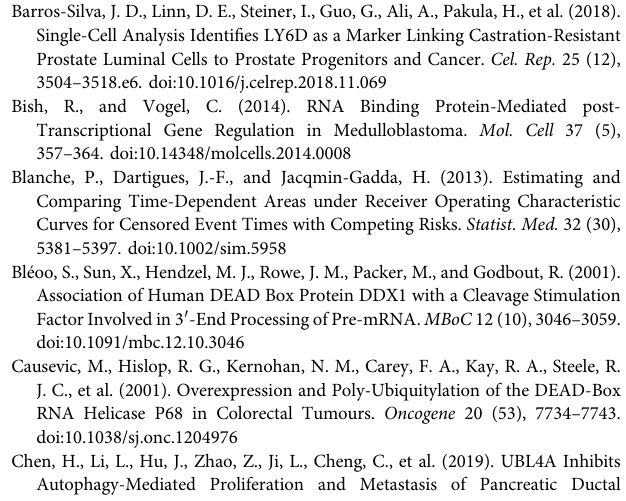
Supplementary Figure S1 | The work fl owchart of analysis. The concrete and distinct work fl owchart of this research was presented. Supplementary Figure S2 | DEG analysis of TCGA and GEO datasets. (A – C) : Up- and downregulated DEGs are shown in the volcano plot. (D) : Unsupervised clustering of viable cells in the KPC-SCRNA dataset. (E) : DEGs between ductal cells and acinar cells are shown in the heat map. SupplementaryFigureS3| Validationofthepredictionabilityoftheriskmodel. (A) : Survival and prognosis of patients in high- and low-risk groups were veri fi ed in the GSE62452 and GSE102238 dataset. Red represents the high-risk group, and blue represents the low-risk group. (B) : Time-dependent ROC curve prediction analysis